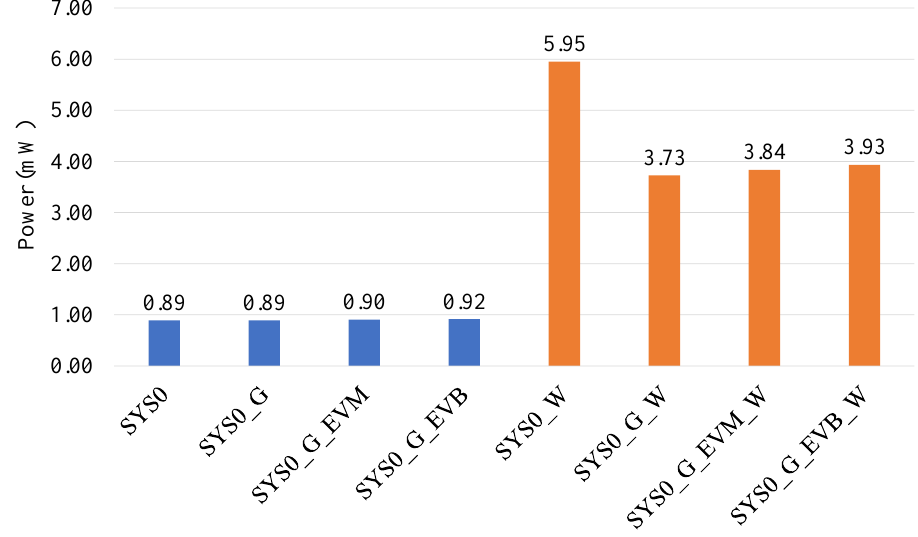
Figure 12. Power consumption for eight different data-handling pipelines running a combination of